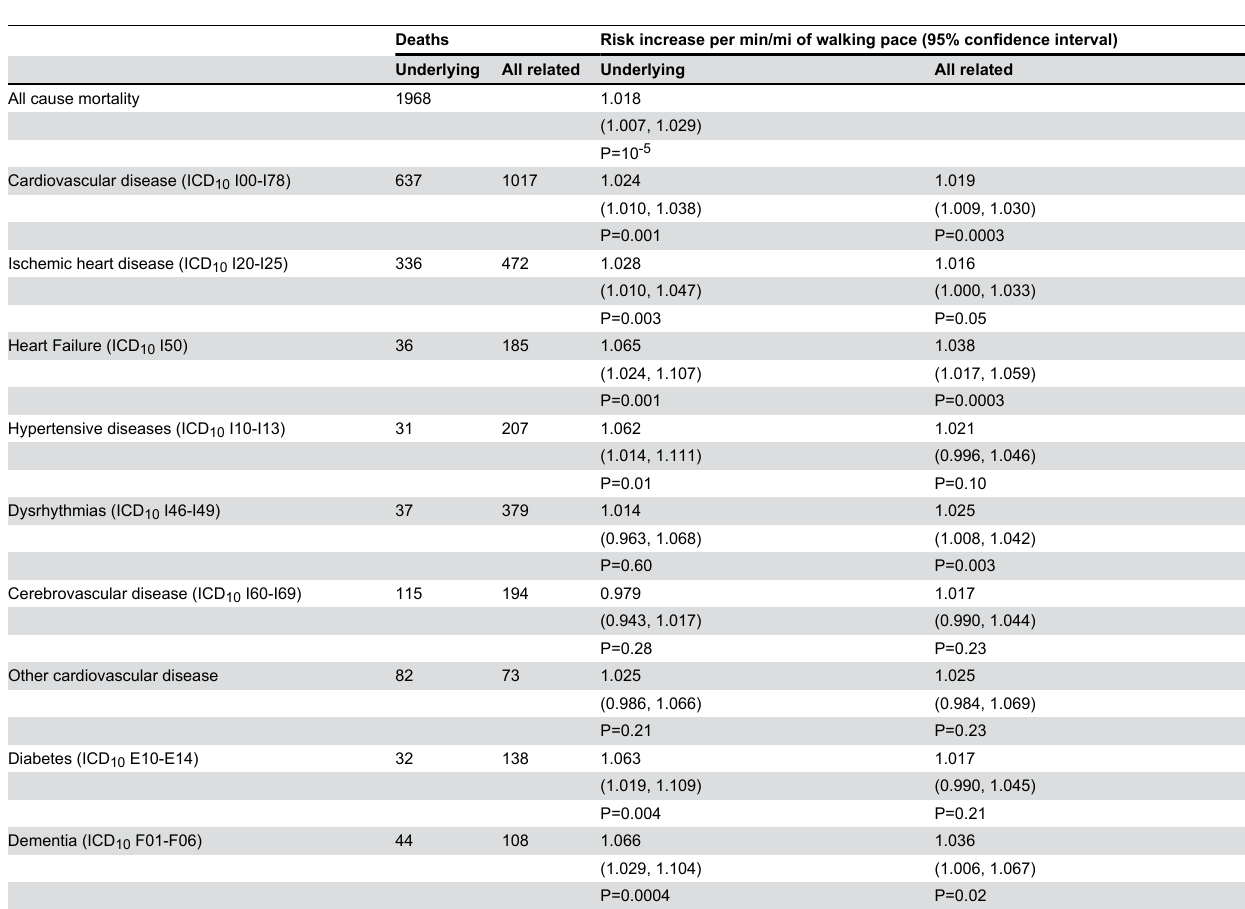
Table 3. Hazard ratios (95% confidence interval) from proportional hazard analyses for cause-specific mortality vs. min/mile walking pace in 38,981 participants of the National Walkers’ Health